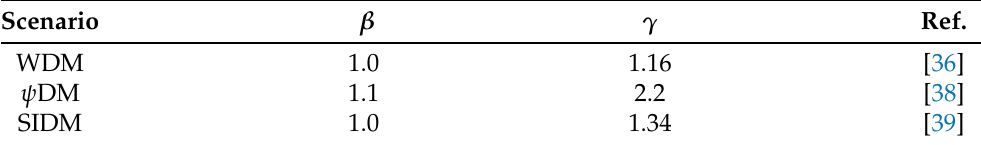
Table 1. Parameters describing the ratio of the halo mass function for different DM scenarios relative to the standard CDM in terms of the expression [ 1 + ( M cut / M H ) β ] − γ , where M H is the halo mass H and M cut is a characteristic cutoff scale; see Section 2.1 for details. The values of the parameters ( β , γ ) , H extracted from the fits to the outcomes of numerical simulations in the considered DM scenarios, are taken from the literature studies referenced in the last